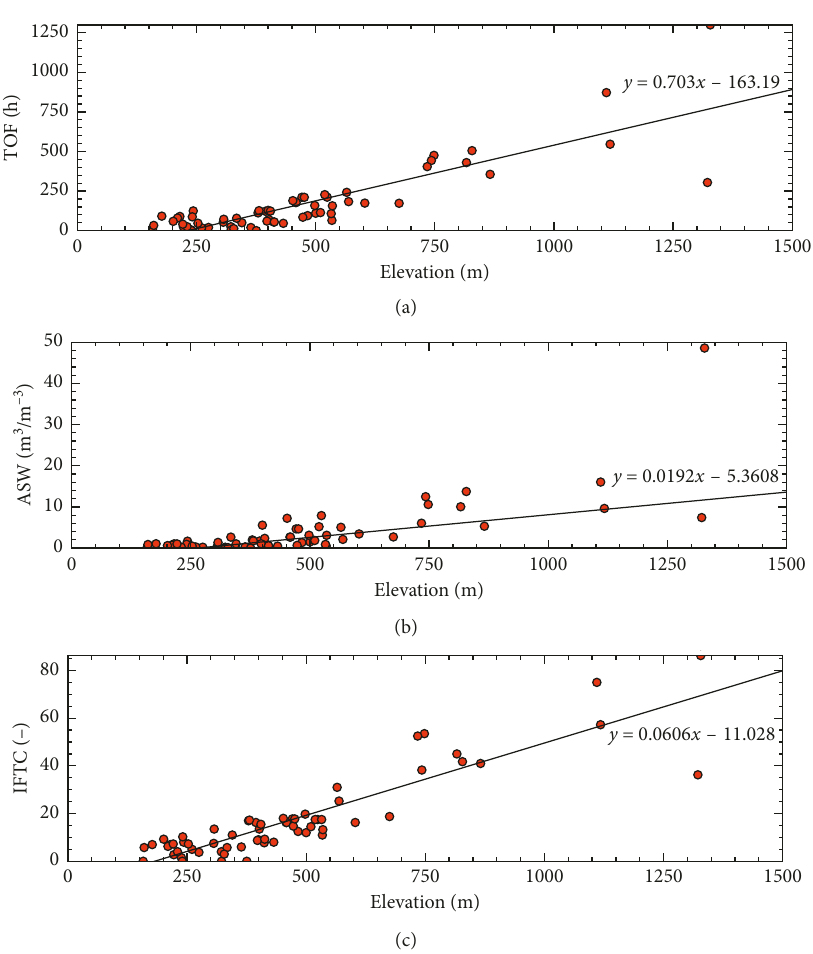
Figure 3: Linear regression of AAC damage function outputs plotted against